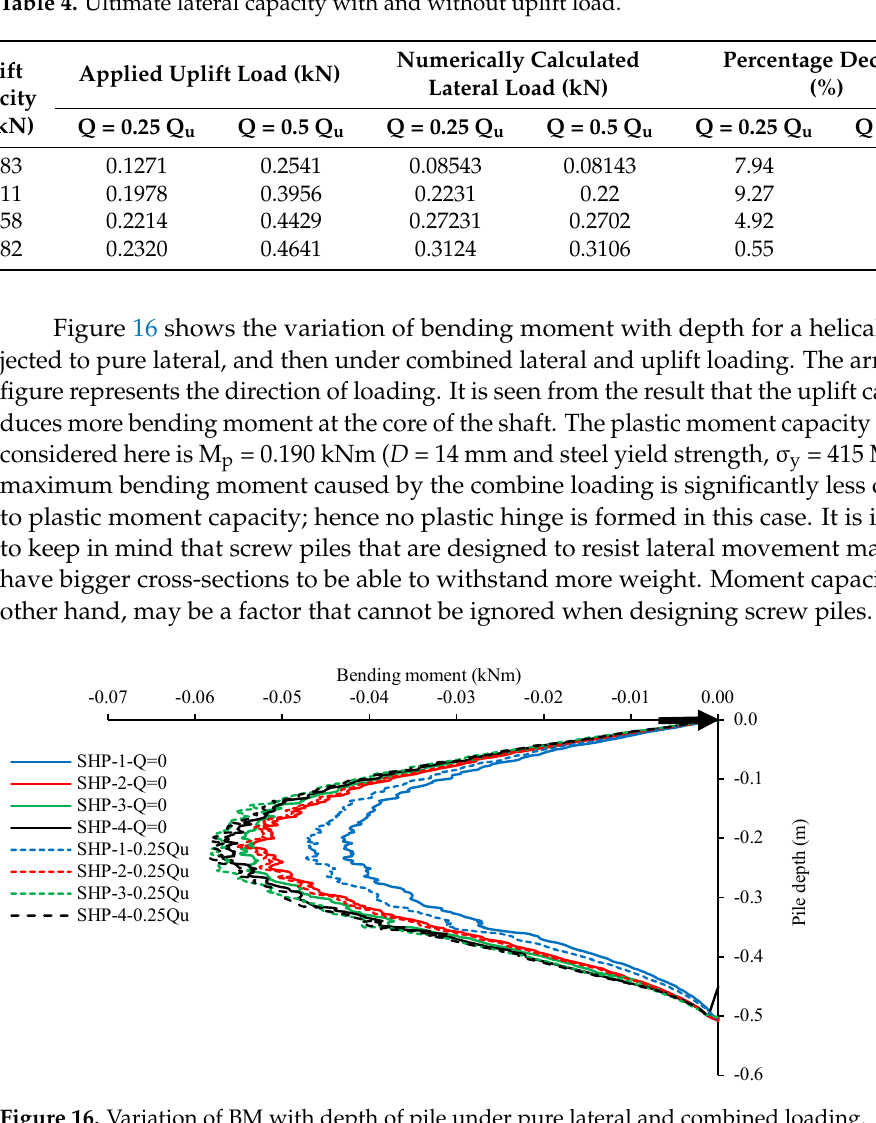
Figure 16. Variation of BM with depth of pile under pure lateral and combined loading.